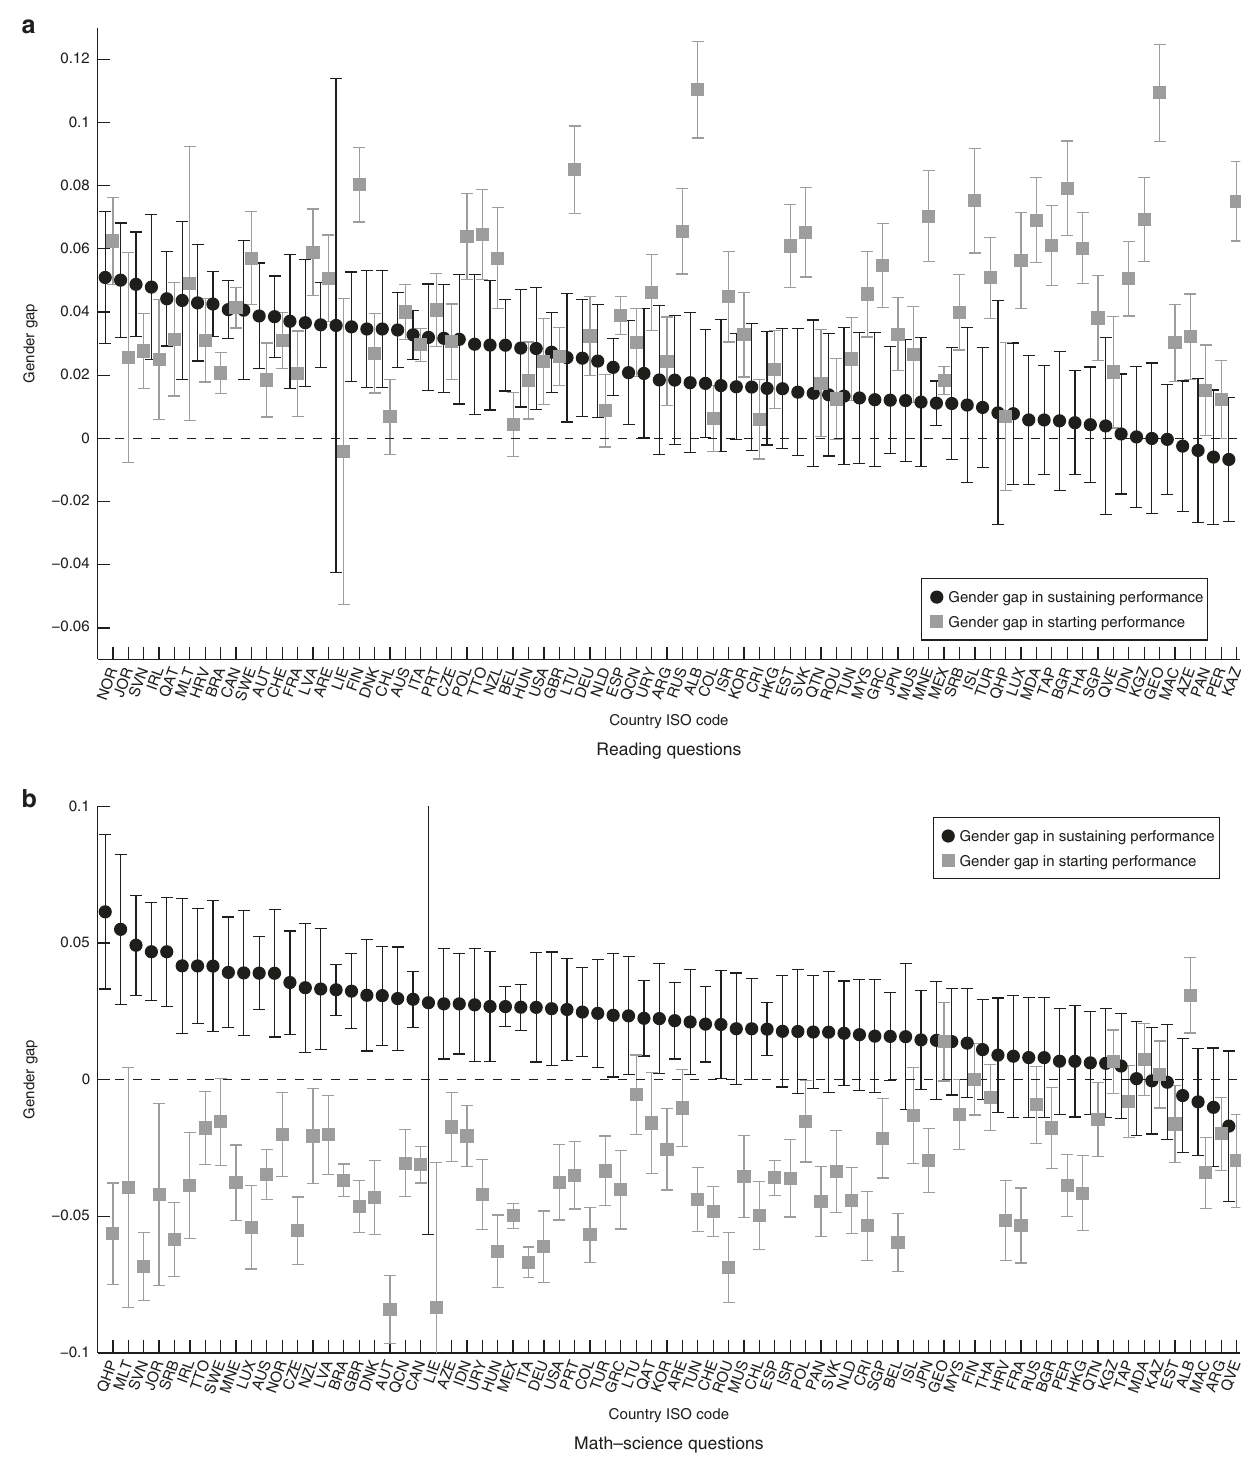
Fig. 3 Gender differences in starting performance and in sustaining performance by topic. The fi gures plot the point estimates of the gender gap in starting performance and in sustaining performance during the test for each country participating in the PISA 2009 for a reading and b math-and-science. Positive values indicate the gender gap favours females. Error bars represent the 95% con fi dence intervals. Source data are provided as a Source Data fi le (study